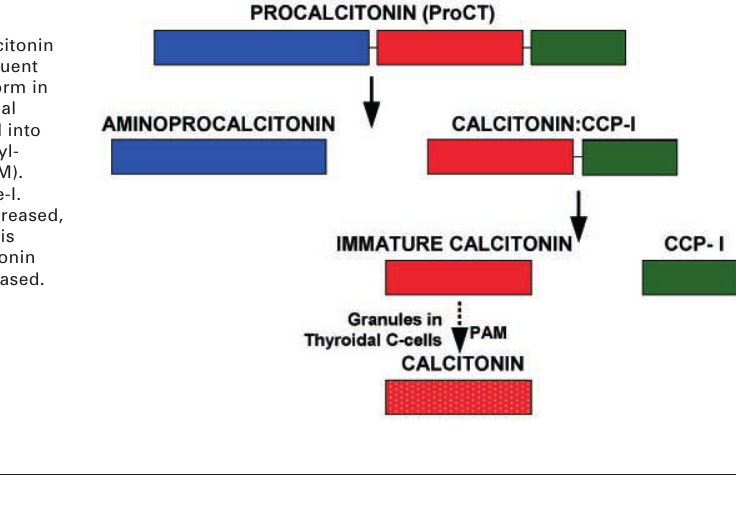
Diagnostic accuracy of sepsis markers. The serum CTpr assay is compared with circulating inter- leukin-6, C-reactive protein, and lactate measurements in critically ill patients with systemic infec- tions (i.e. sepsis, se- vere sepsis, or septic shock) on admission. They are displayed in a receiver operating curve (ROC) analysis (adapted from [2]).